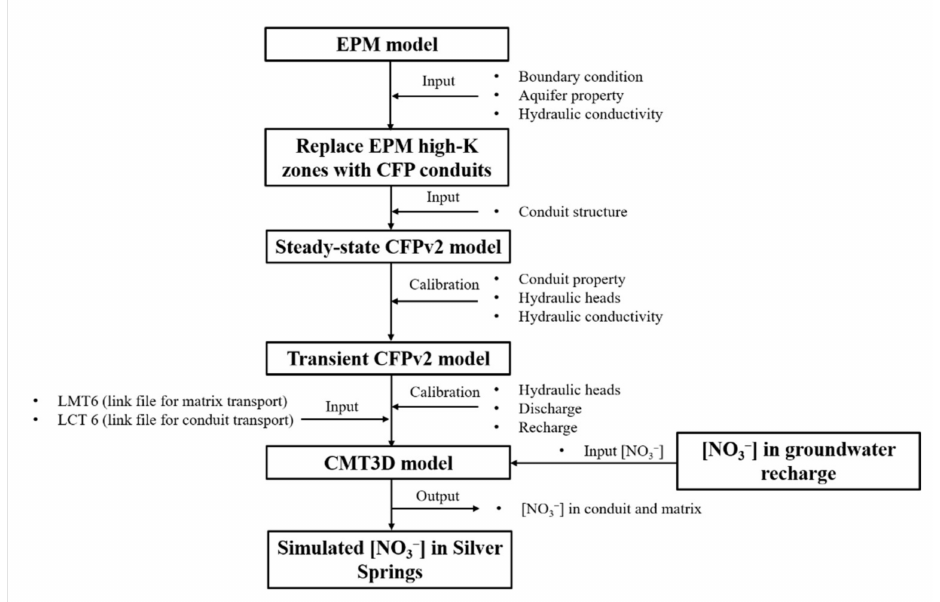
Figure 3. The procedures for modeling nitrate concentration in Silver